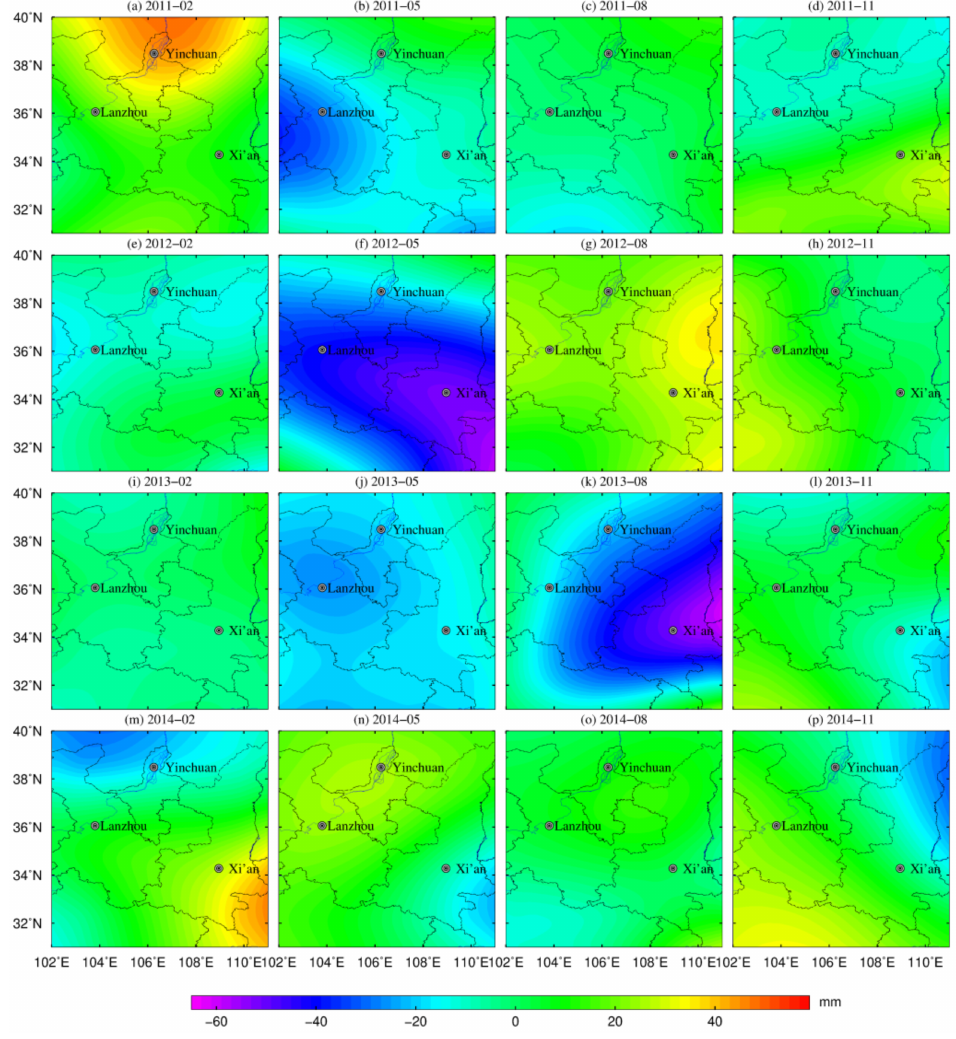
Figure 10. Spatiotemporal distribution of regional GWS derived from GRACE from 2011 to 2014.